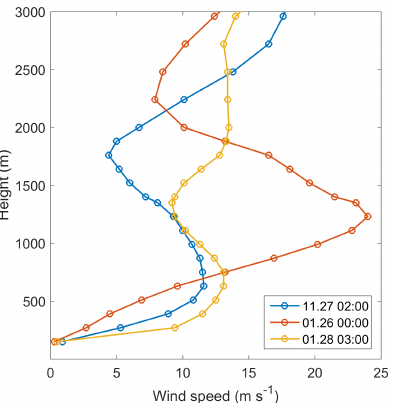
Figure 9. Sample LLJ profiles for three transitions between CSs and TSs.